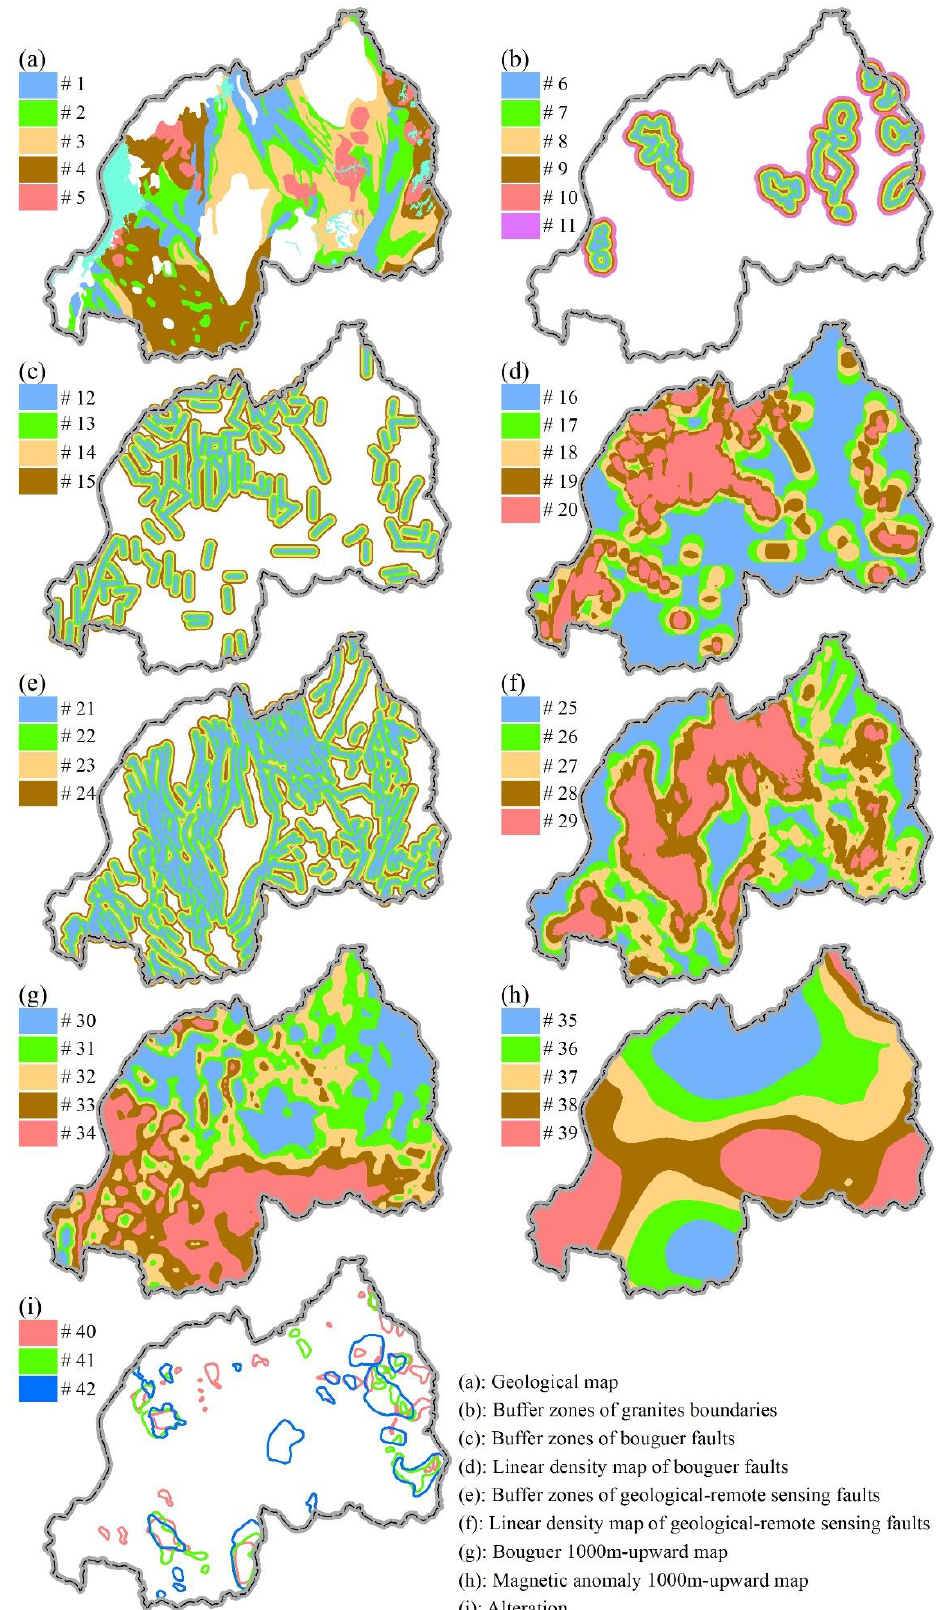
Figure 3. Relevant layers involved in this study.